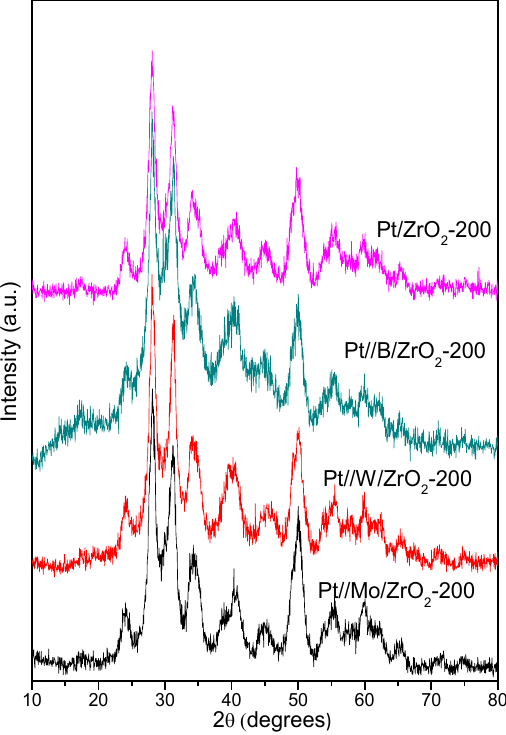
Figure 1. XRD patterns corresponding to catalysts used in this work.